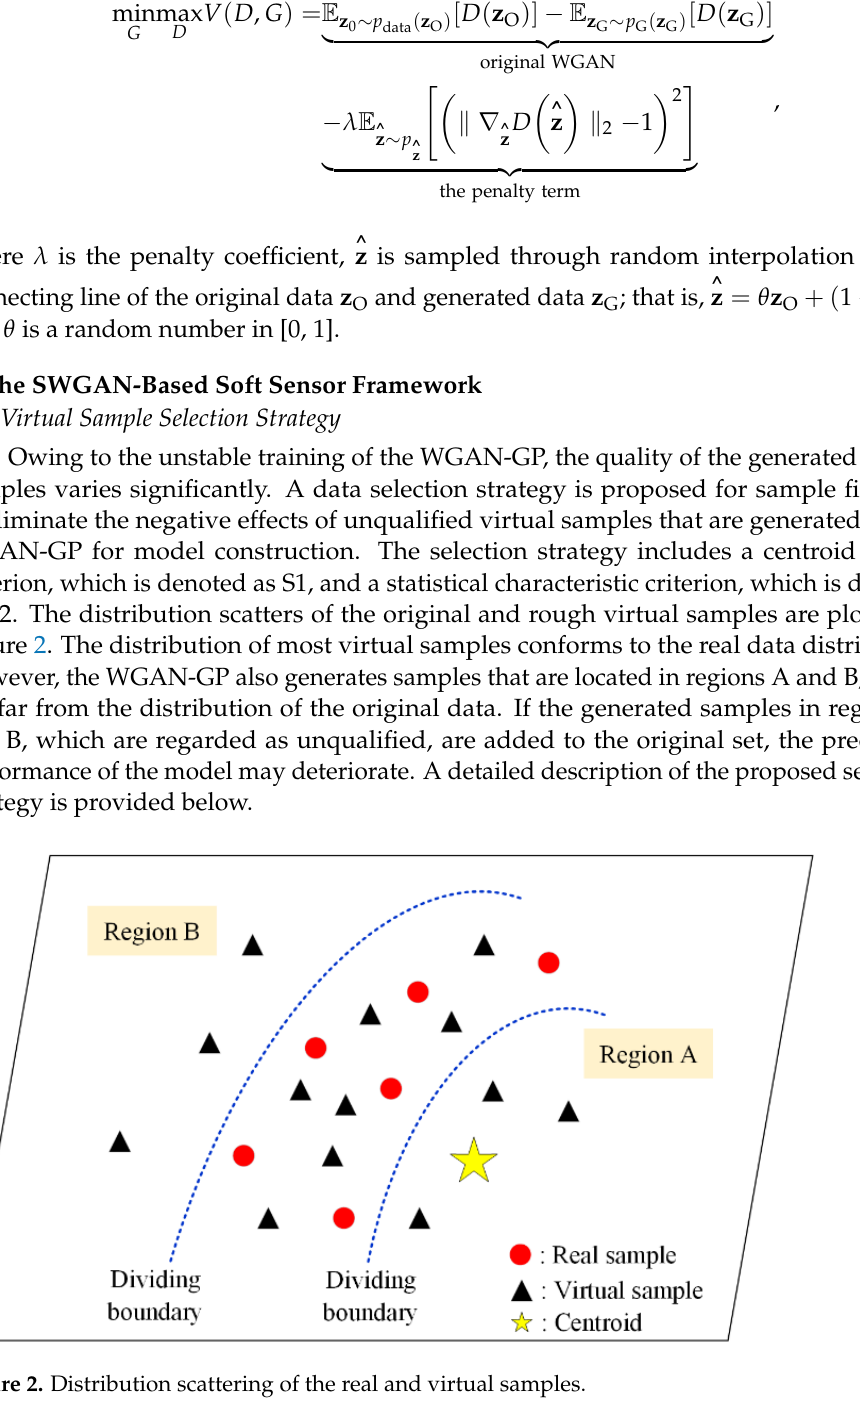
Figure 2. Distribution scattering of the real and virtual samples. First, the S1 criterion is developed to filter the virtual samples in region A. The samples in region A are too close to the centroid z C of the original samples. Furthermore, the distribution of these samples is not uniform compared to that of the original sample. Thus, the virtual samples around the centroid are considered to be information-poor